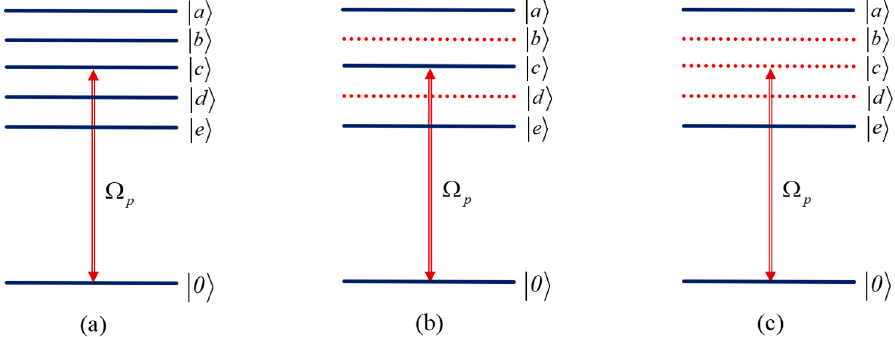
Figure 3. Dressed states of the MQDs with five dots under the tunneling coupling and for varying condition of energy splitting of the exciton states, ( a ) ω 12 (cid:54) = ω 13 (cid:54) = ω 14 (cid:54) = ω 15 ; ( b ) ω 12 = ω 13 (cid:54) = ω 14 = ω 15 ; ( c ) ω 12 = ω 13 = ω 14 = ω 15